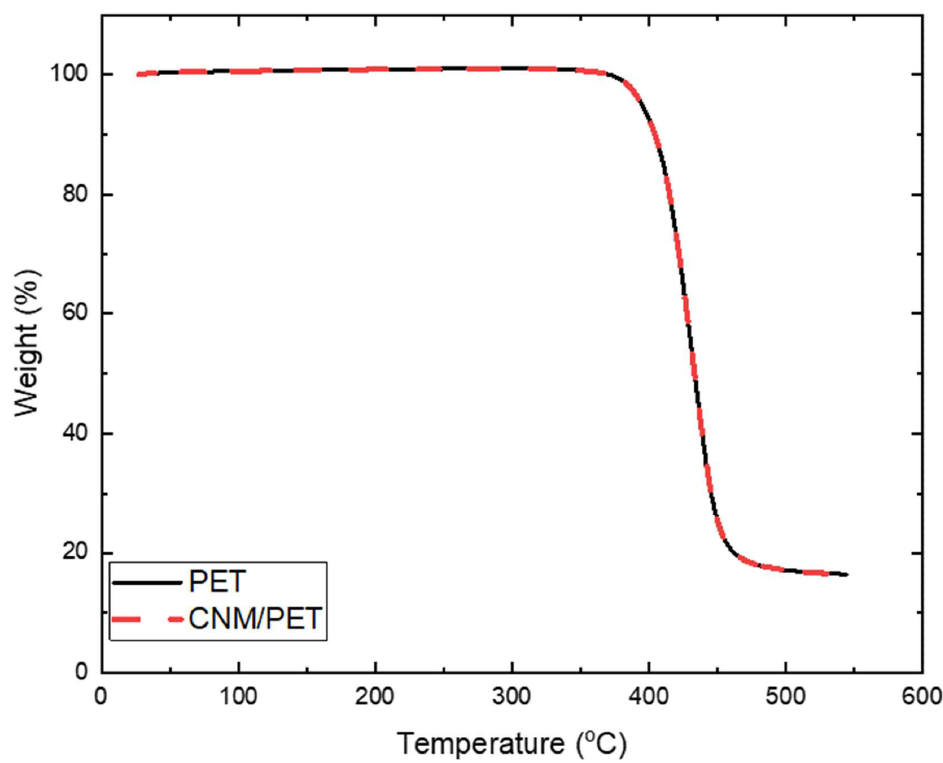
Figure 9. Thermogravimetric results of CNM/PET